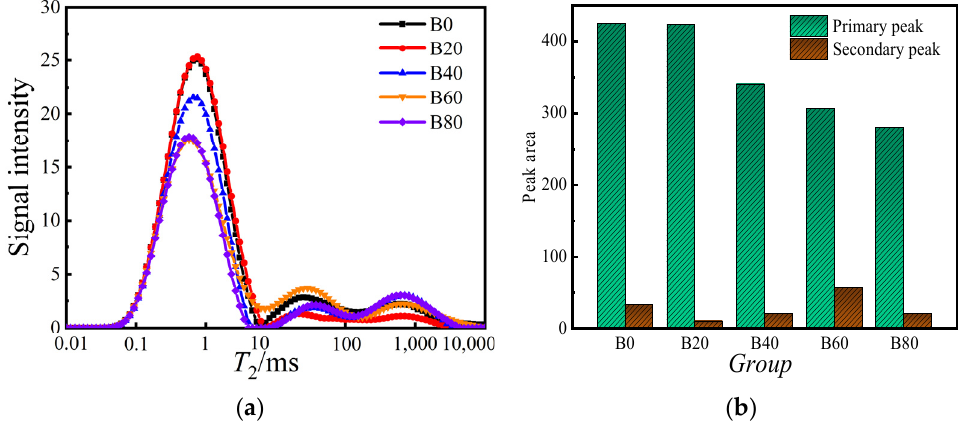
Figure 10. T 2 spectrum and peak area: ( a ) T 2 spectrum; ( b ) peak area.